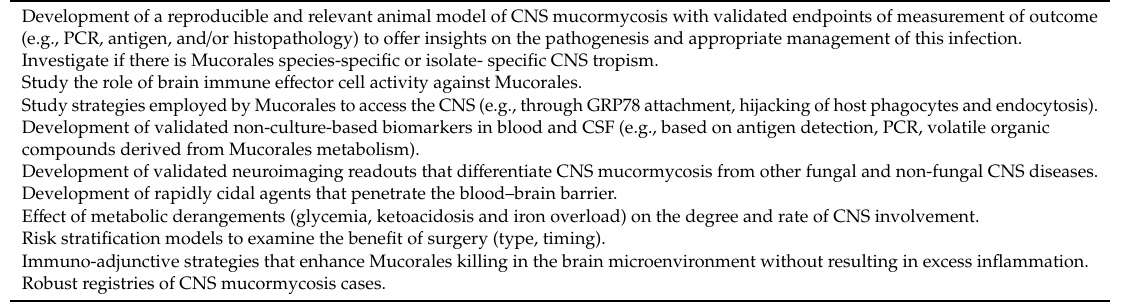
Table 3. Unmet needs in the study and management of CNS